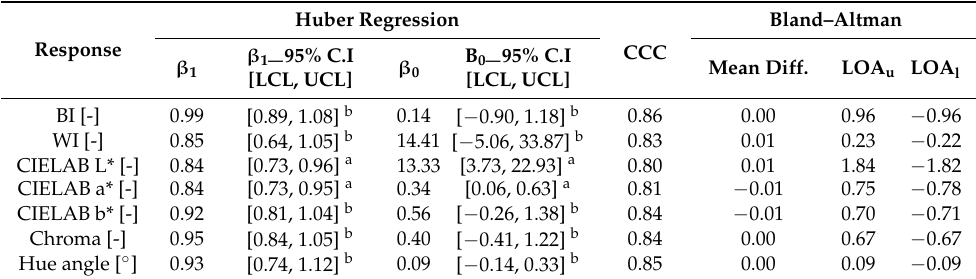
Table 5. Method comparison metrics for colour attributes.